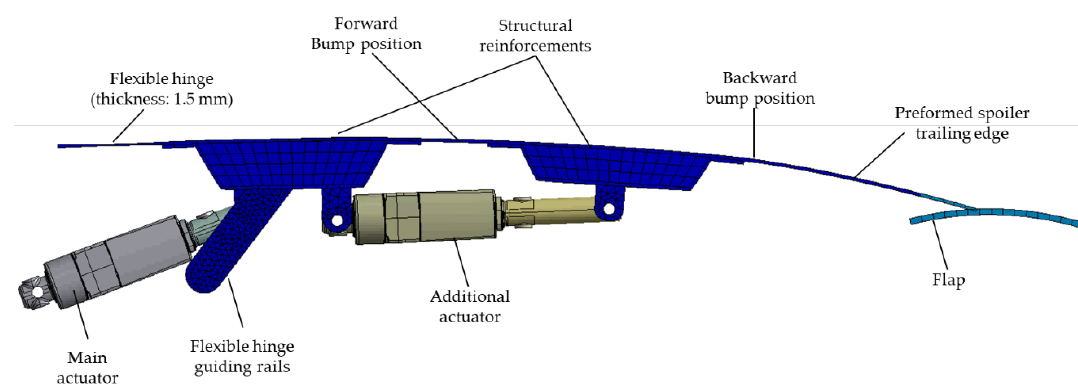
Figure 3. Two-actuator concept of an adaptive preformed spoiler bump system based on [67].